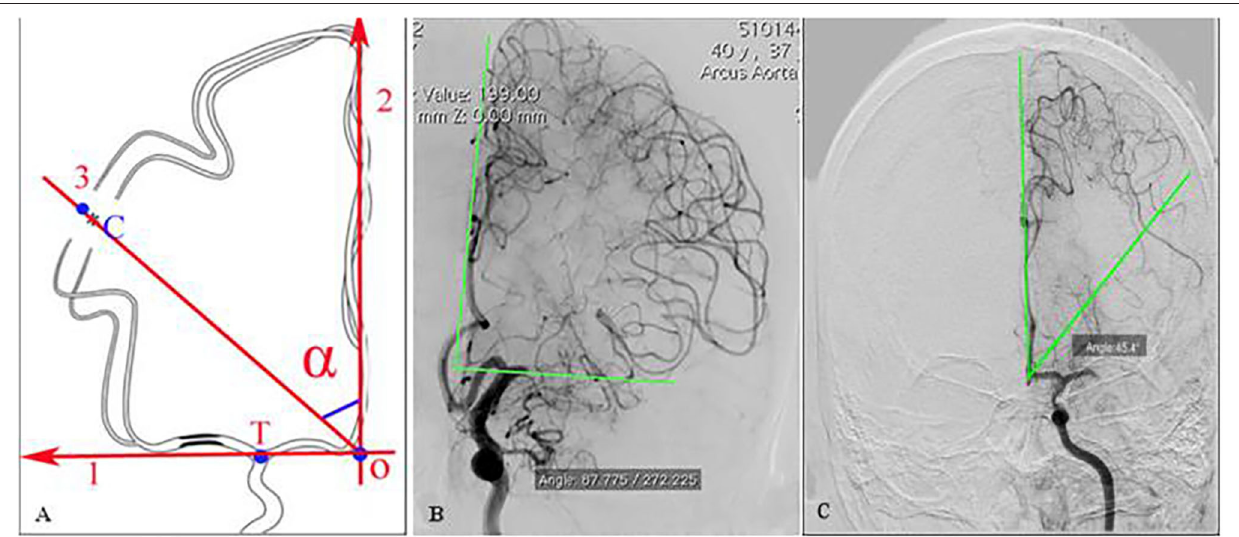
FIGURE 2 | Definition of ABZA on DSA image (with permission) (6). (A) determine point T at the intracranial bifurcation of ICA, find the midline 2, that is, the projection of sagittal sinus, the vertex O is obtained from the vertical projection of point T on midline 2, and determine the central point C of the boundary zone of ACA-MCA,